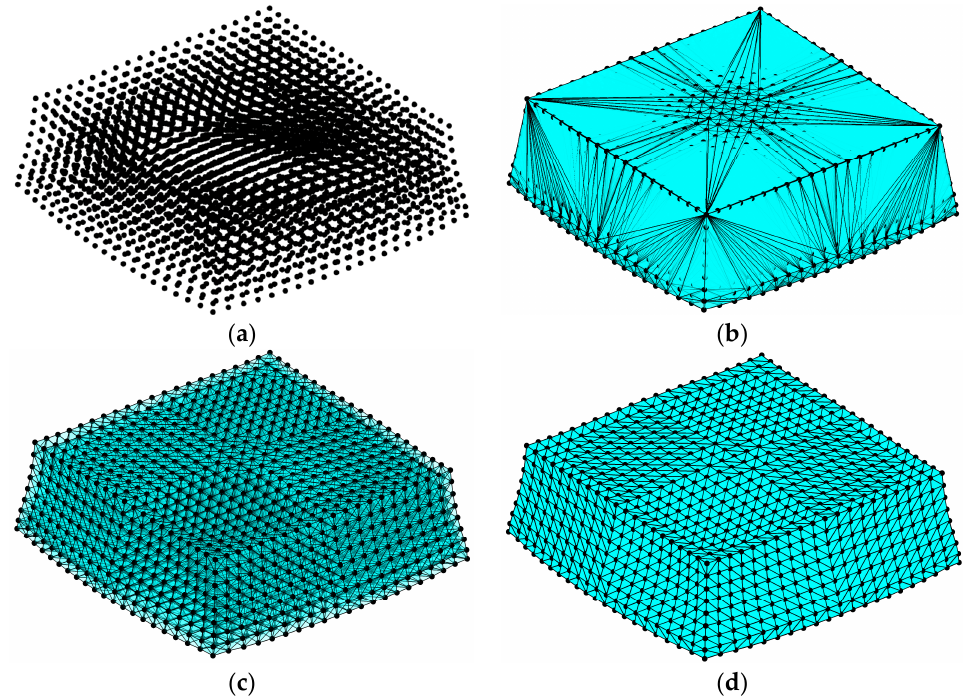
Figure 1. Surface reconstruction for an 3D SPH object: ( a ) Particles representing the object; ( b ) Tetrahedrons obtained by Delaunay triangulation of particles; ( c ) Remaining tetrahedrons (including internal faces); ( d ) Reconstructed surface of the object (no internal faces).